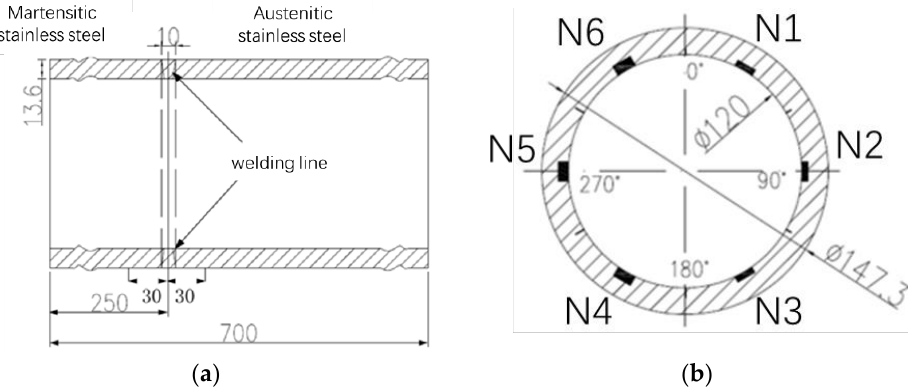
Figure 2. The detected circumferential weld: ( a ) the side view of the mockup; ( b ) the cross-section view of the mockup.